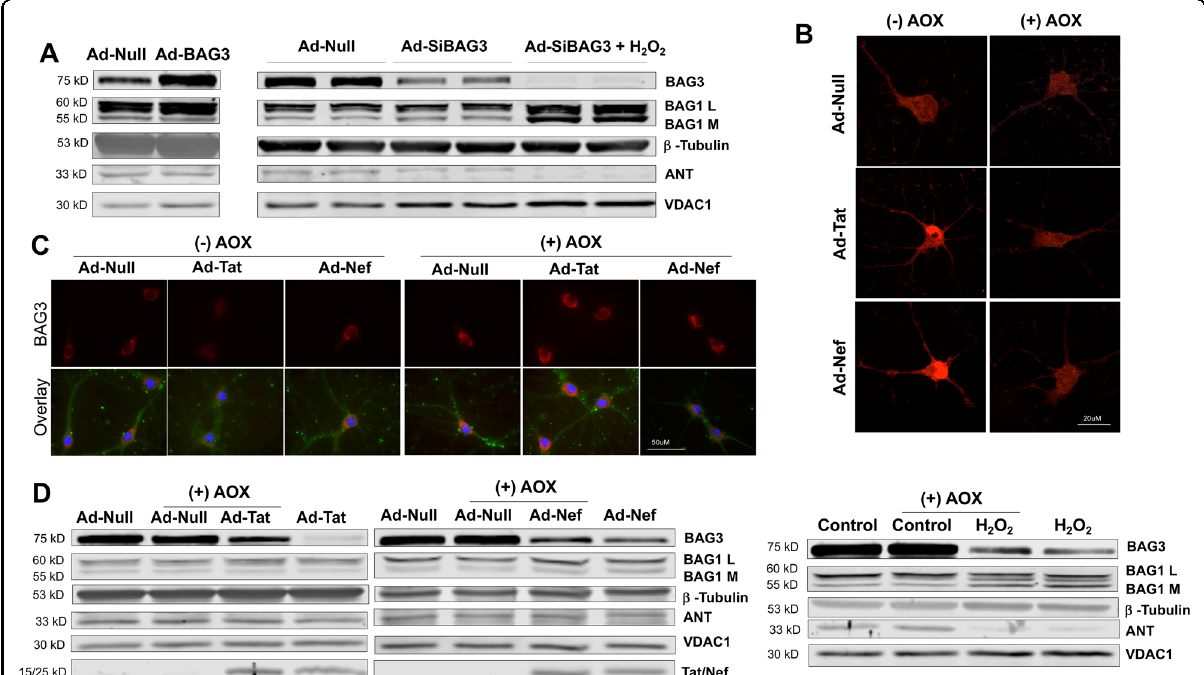
Fig. 4 H 2 O 2 -sensitive proteins and antioxidant effects on BAG3. A Immunoblotting results indicated H 2 O 2 treatment following BAG3 knockdown in neurons resulted in increased BAG1 protein, but alterations in BAG1 were not observed following the overexpression or knockdown of BAG3 alone; moreover, decreases in BAG3 were correlated with increased dysregulation of proteins responsible for maintaining mitochondrial membrane permeability, VDAC1, and ANT. B Live-cell microscopy indicated antioxidant treatment inhibited the increase in ROS otherwise induced by viral protein expression. C Immunocytochemistry suggested a decrease in neuronal oxidative stress was capable of partially preserving BAG3 protein levels. D Compared to control conditions, antioxidant treatment was not capable of fully preserving BAG3 levels, nor was it capable of inhibiting the dysregulation of mitochondrial proteins. Scale bar equals 20 μ M; ×60 magni fi cation. Scale bar equals 50 μ M; ×100 magni fi